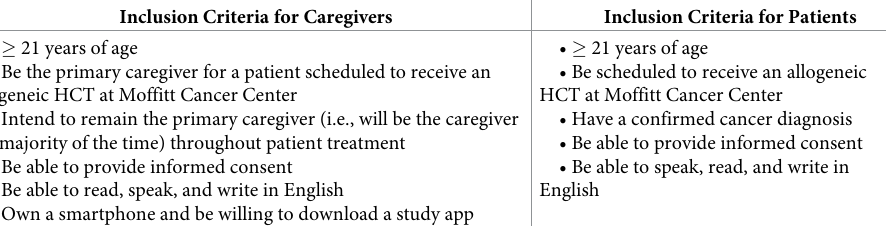
Table 1. Eligibility